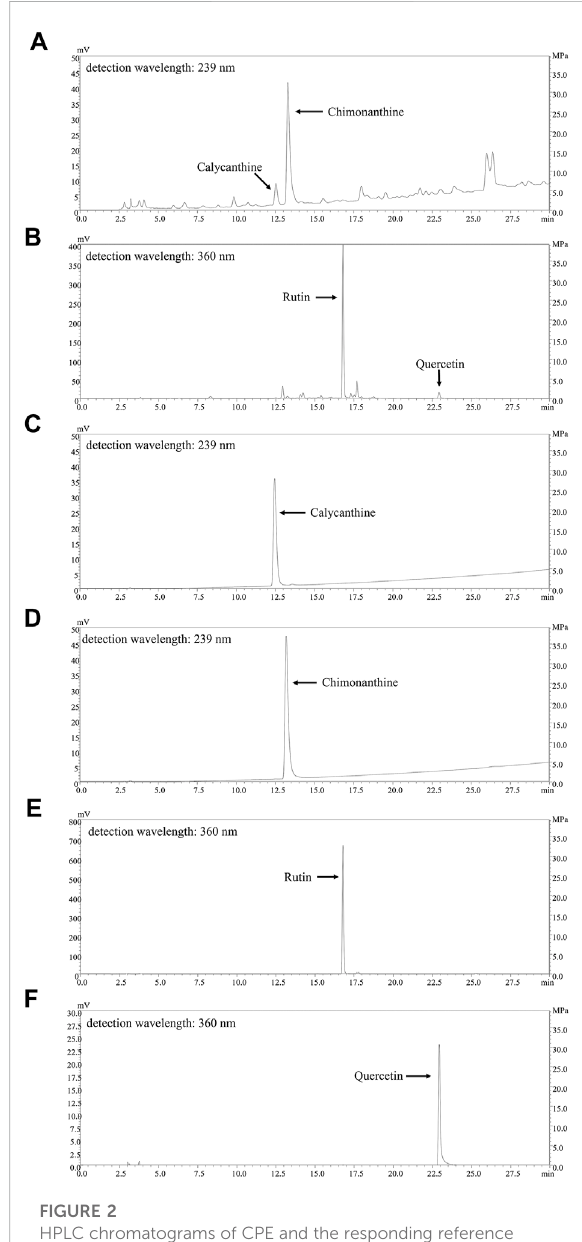
FIGURE 2 HPLC chromatograms of CPE and the responding reference substances. (A,B) The fi ngerprints of the alkaloids of CPE (A) and the fl avonoids of CPE (B) . (C – F) The HPLC chromatograms of